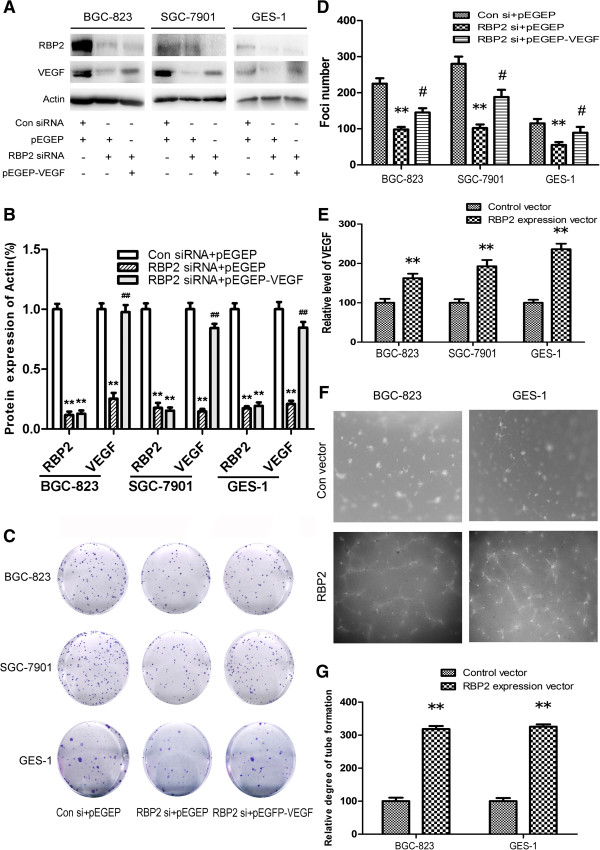
Promotion of tumorgenesis and angiogenesis by RBP2-induced VEGF expression in vitro. (A, B) Western blot analysis of RBP2 and VEGF protein levels in cancer cells treated with control and RBP2 siRNA or cotransfection of RBP2 siRNA and VEGF expression vector. **P < 0.01 vs control, ##P < 0.01 vs RBP2 siRNA + pEGEP. (C) Foci formation of human gastric cancer cells after treatment with control and RBP2 siRNA or cotransfection of RBP2 siRNA and VEGF expression vector. (D) The foci numbers of clones. **P < 0.01 vs control. #P < 0.05 vs RBP2 siRNA + pEGEP. (E) ELISA results for VEGF concentration in cell cultures treated with control vector and RBP2 expression vector. **P < 0.01. (F) Tube formation in HUVEC cells treated with the supernatants from the cells transfected with control vector and RBP2 expression vector. (G) Tube formation calculated as the percentage of cell surface area to the total surface area. The group incubated with the control cell cultures were set to 100%. **P < 0.01. Data are mean ± SEM of 3 independent experiments.